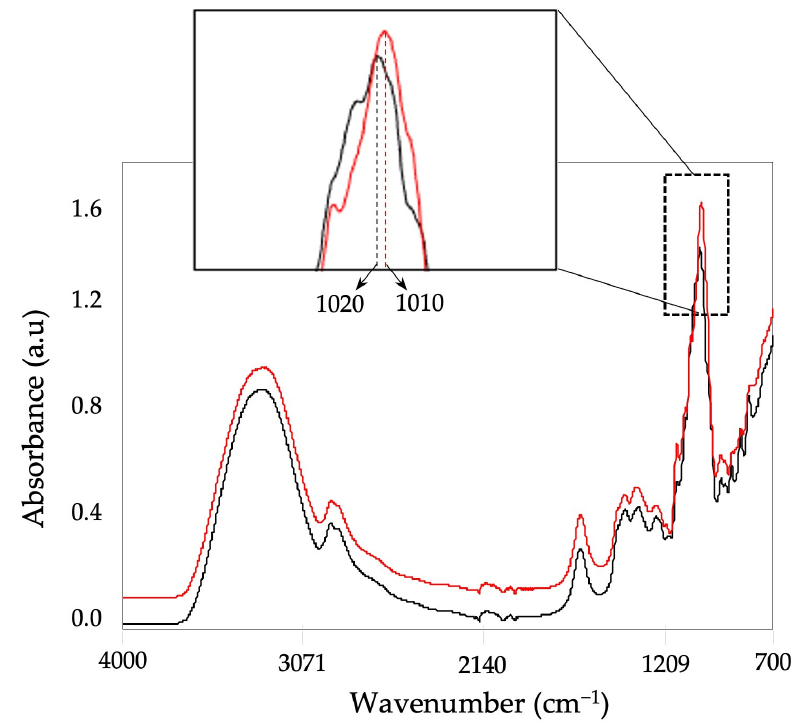
Figure 1. Average raw spectra of the pure honey samples and suspicious samples with high sucrose concentration (>5%). The spectra were collected using a portable FT-IR sensor at a range of 4000–700 cm − 1 . The red line demonstrates the suspicious sample with high sucrose content, the black line is the pure honey. *arbitrary units.